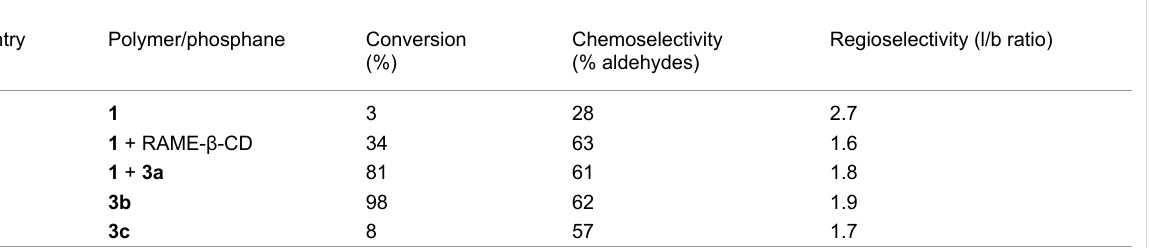
Table 1: Rh-catalyzed hydroformylation of 1-hexadecene.